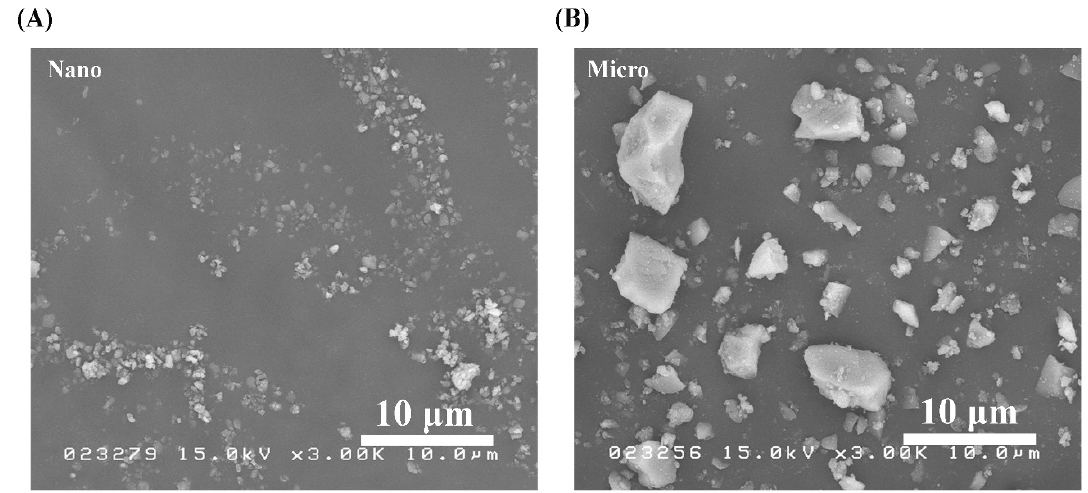
Figure 1. SEM images of pure S-PRG ( A ) nanoparticles and ( B ) microparticles. Polygonal particles were observed in both cases.